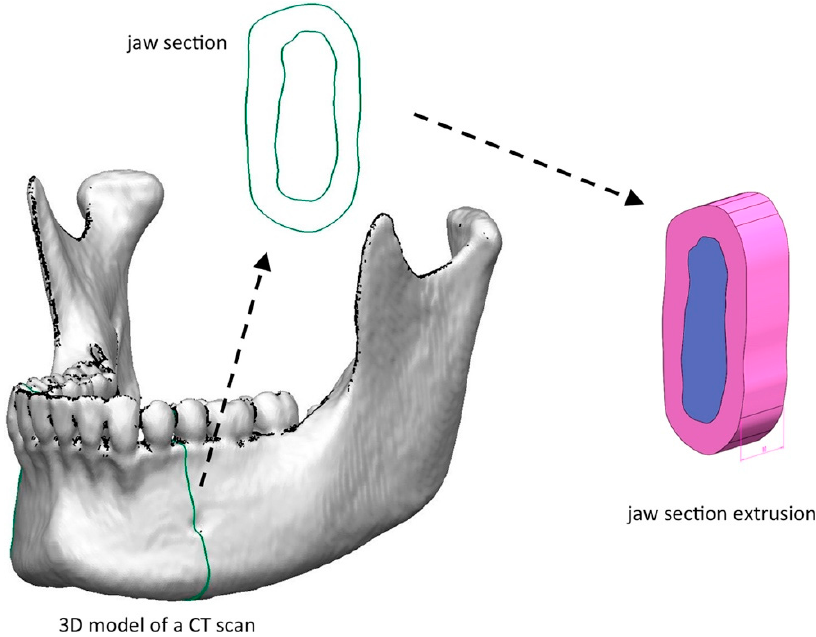
Figure 4. From radiographic images (.dicom files) to .stl. All rights reserved